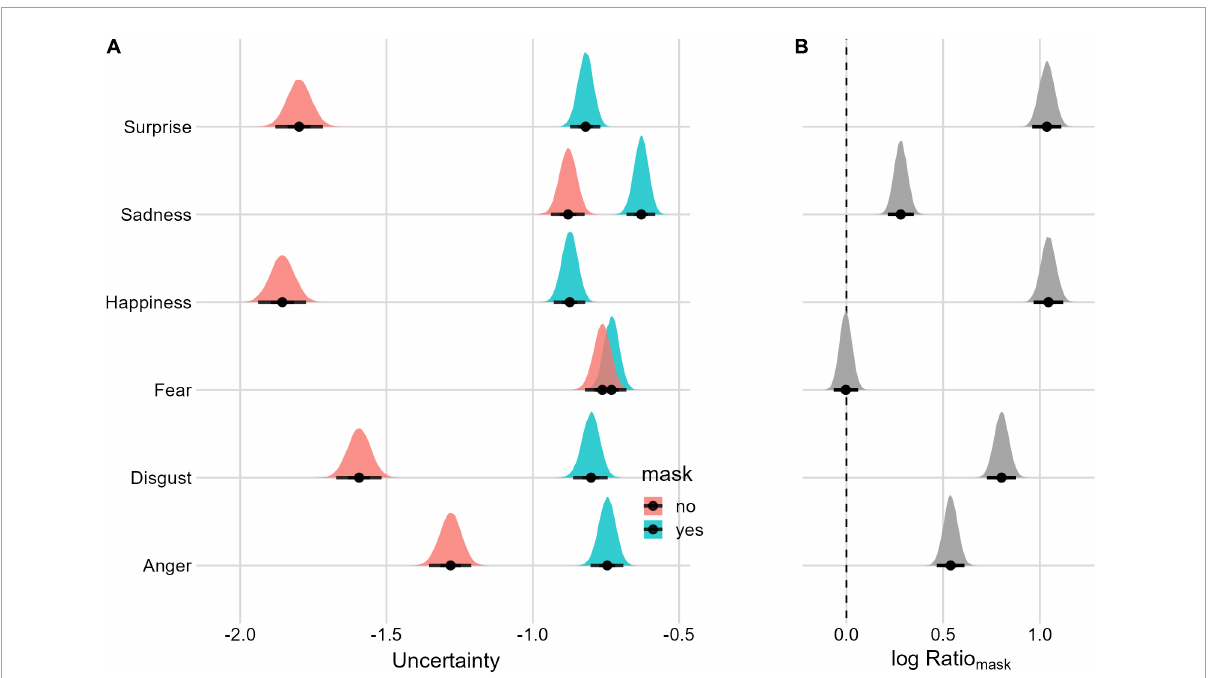
FIGURE5 Posterior distributions and 95% HPDIs of the uncertainty Mask effect (A) uncertainty posterior distributions as a function of the Mask condition. (B) Posterior distribution of the Mask Ratio (Mask yes /Mask no ). Values are plotted on the logarithm scale for better visualization (the null value is 0).